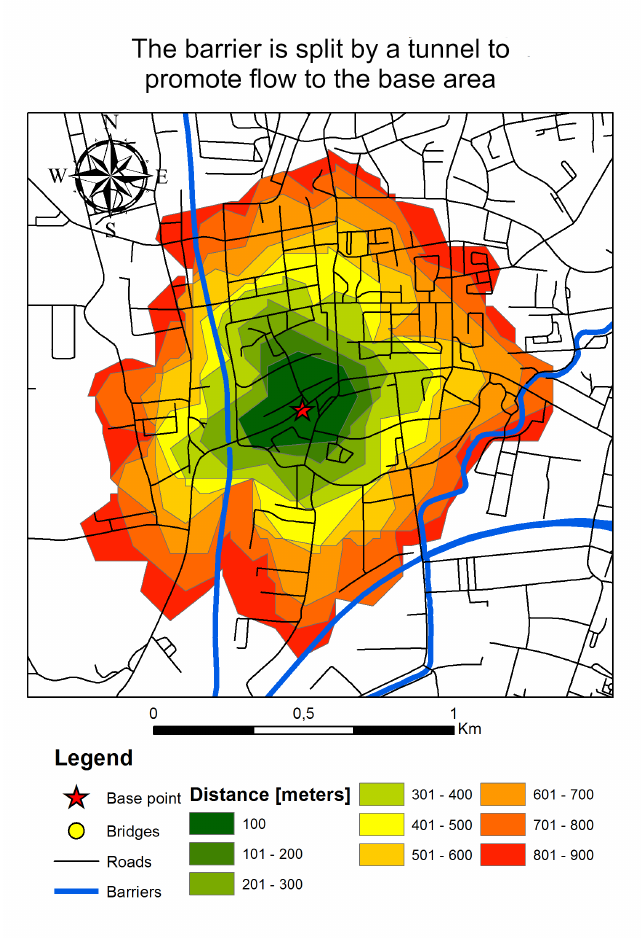
Figure 4. A road network developed in view of linear barriers and a service area. Service area polygons do not account for